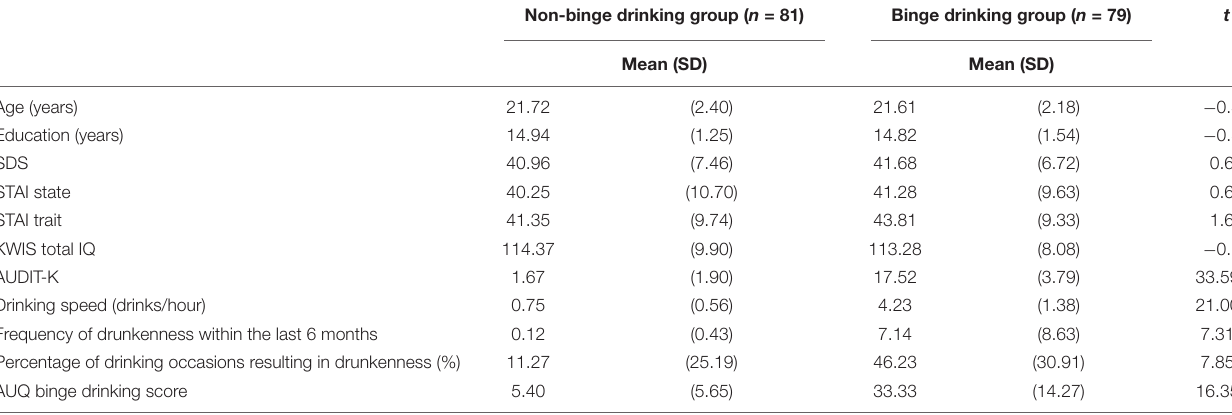
TABLE 1 | Demographic characteristics of the binge drinking and non-binge drinking groups.